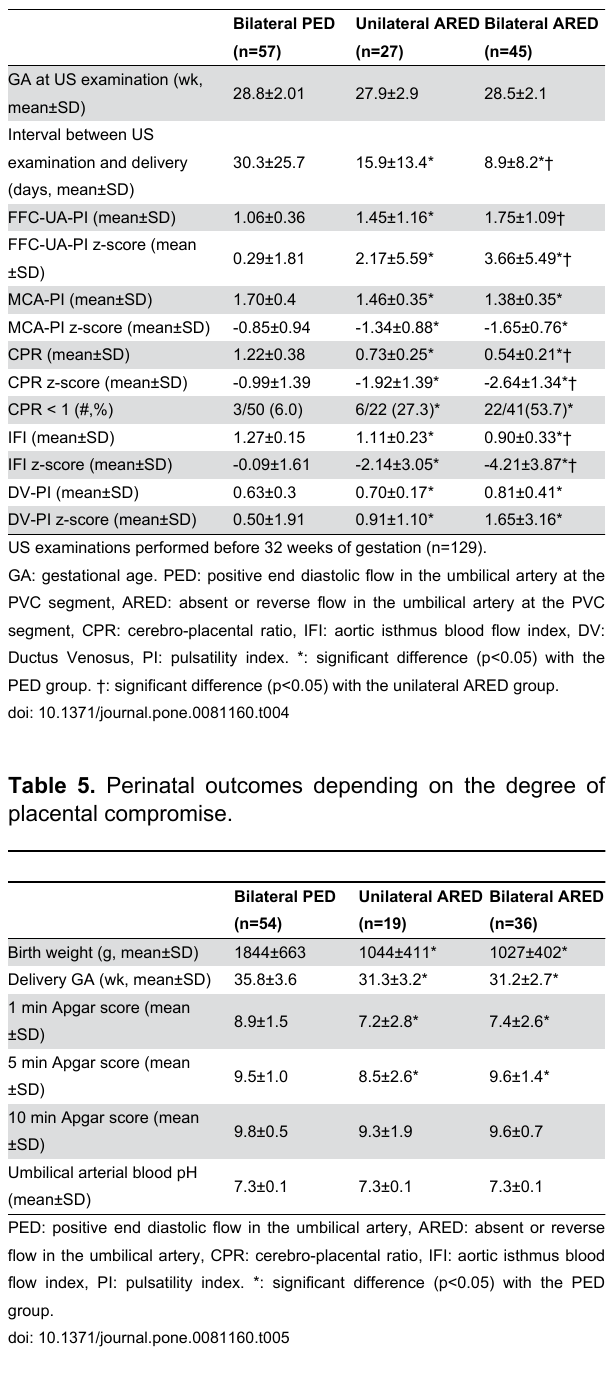
Umbilical arterial blood